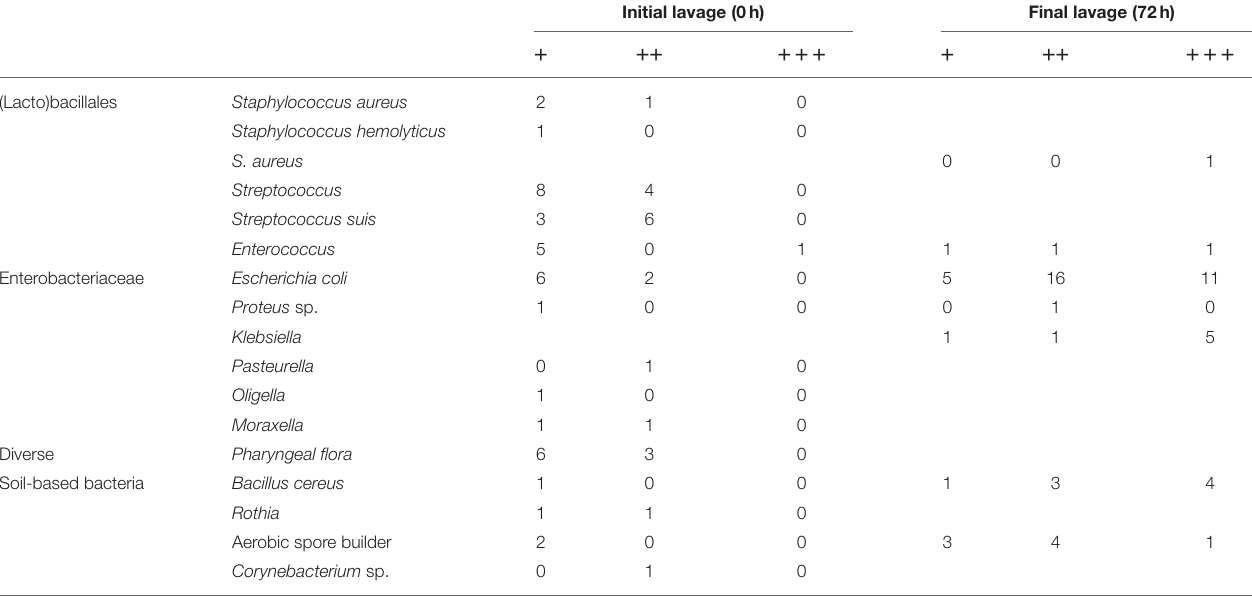
TABLE 5 | Bacteria in airways.